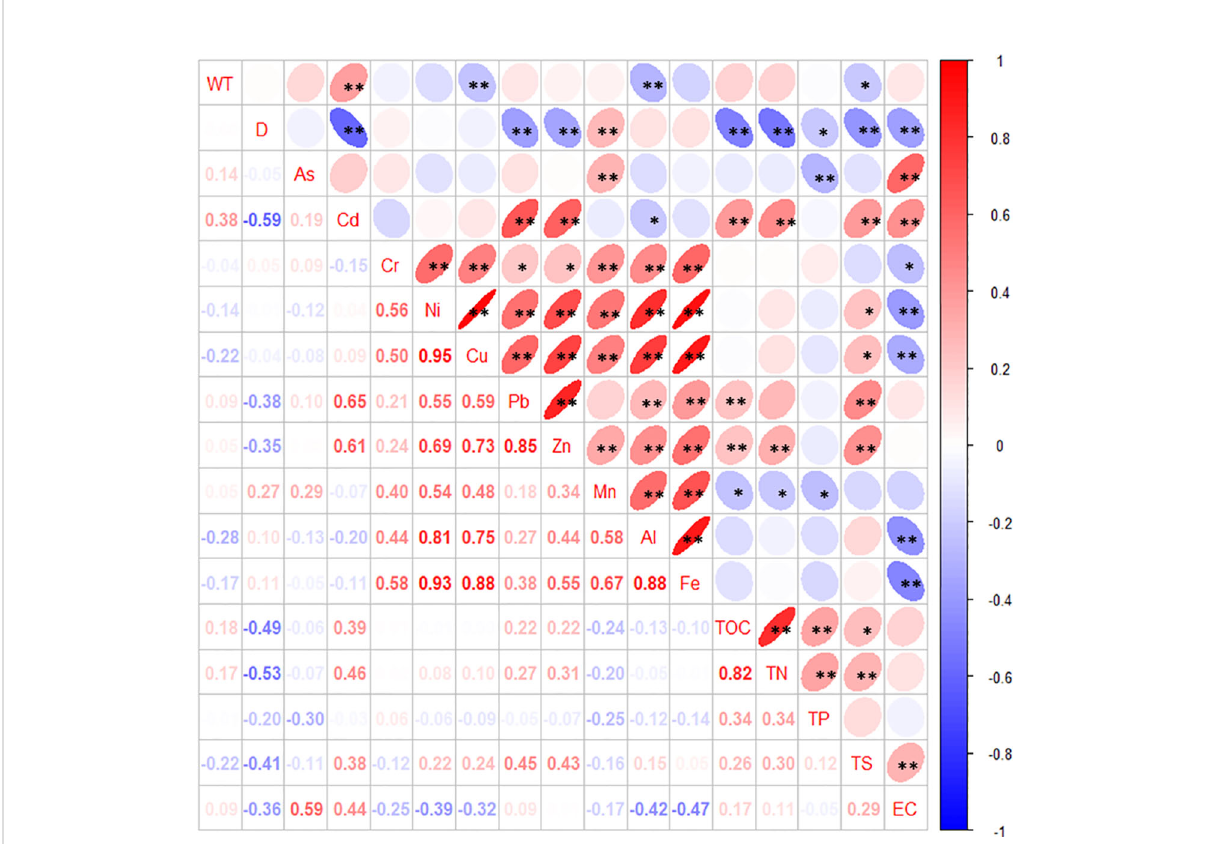
FIGURE 5 Spearman ’ s correlation analysis between metals and soil characteristics. WT , wetland type; D , depth. Red denotes a positive interaction and blue represents negative interaction. Lighter color indicates weaker correlation. *Correlation is signi fi cant at the 0.05 level (two-tailed). **Correlation is signi fi cant at the 0.01 level